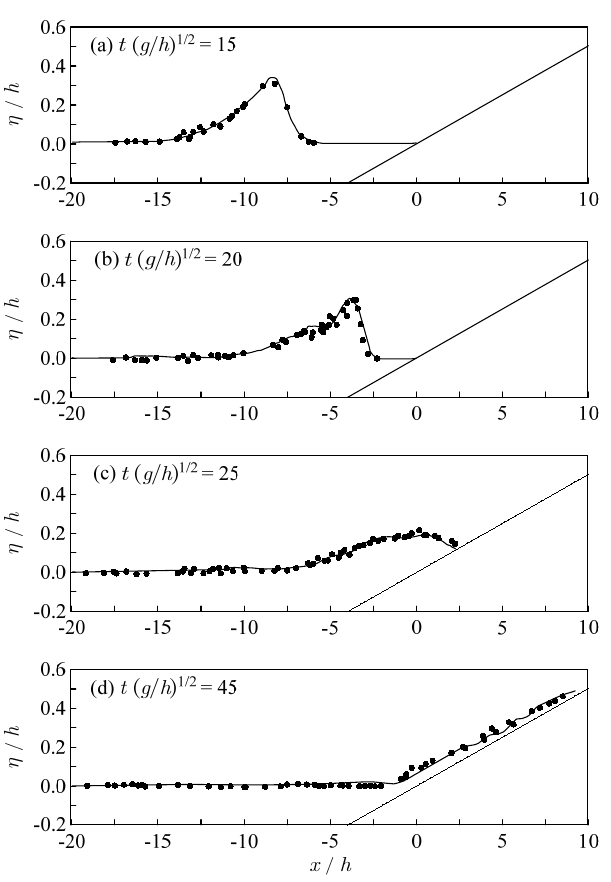
Figure 3. Comparison of solitary wave propagating from breaking and run-up at four time instances between the present numerical model ( － ) and the laboratory experiments ( ● ) of Synolakis (1986) on uniform slope of 1:19.85.